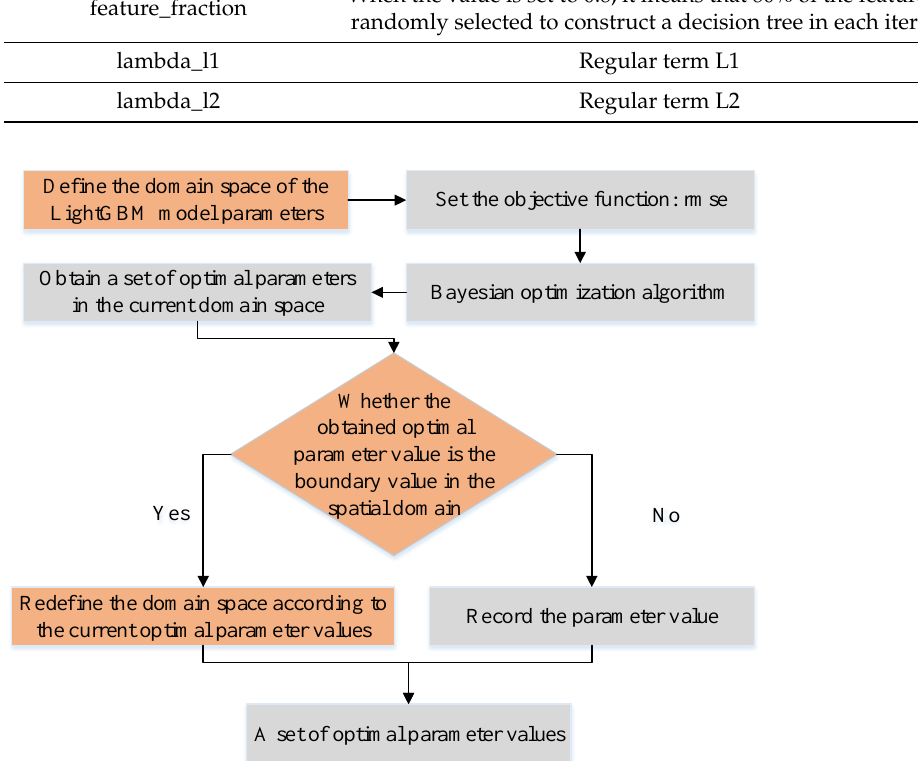
Figure 9. Bayesian optimization algorithm parameter iteration process.